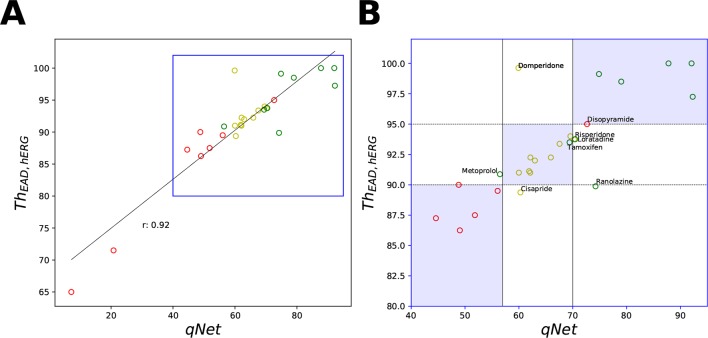
Scatter plot of qNet vs ThEAD,hERG metrics. (A) For all the 28 “CiPA drugs” a high correlation of 0.92 was observed. A region of interest is expanded in (B) to show details of separation among the drugs across the independently determined ranges for low, intermediate, and high risk based on qNet (solid black lines) and ThEAD,hERG (dotted black lines) metrics. Blue regions show where both the qNet and ThEAD,hERG metric agree. The high-, intermediate-, and low-risk drugs are colored in red, yellow, and green, respectively, based on their torsadogenic risk. See the
Supplemental Material
 for an additional plot of APD90 vs ThEAD,hERG metrics.